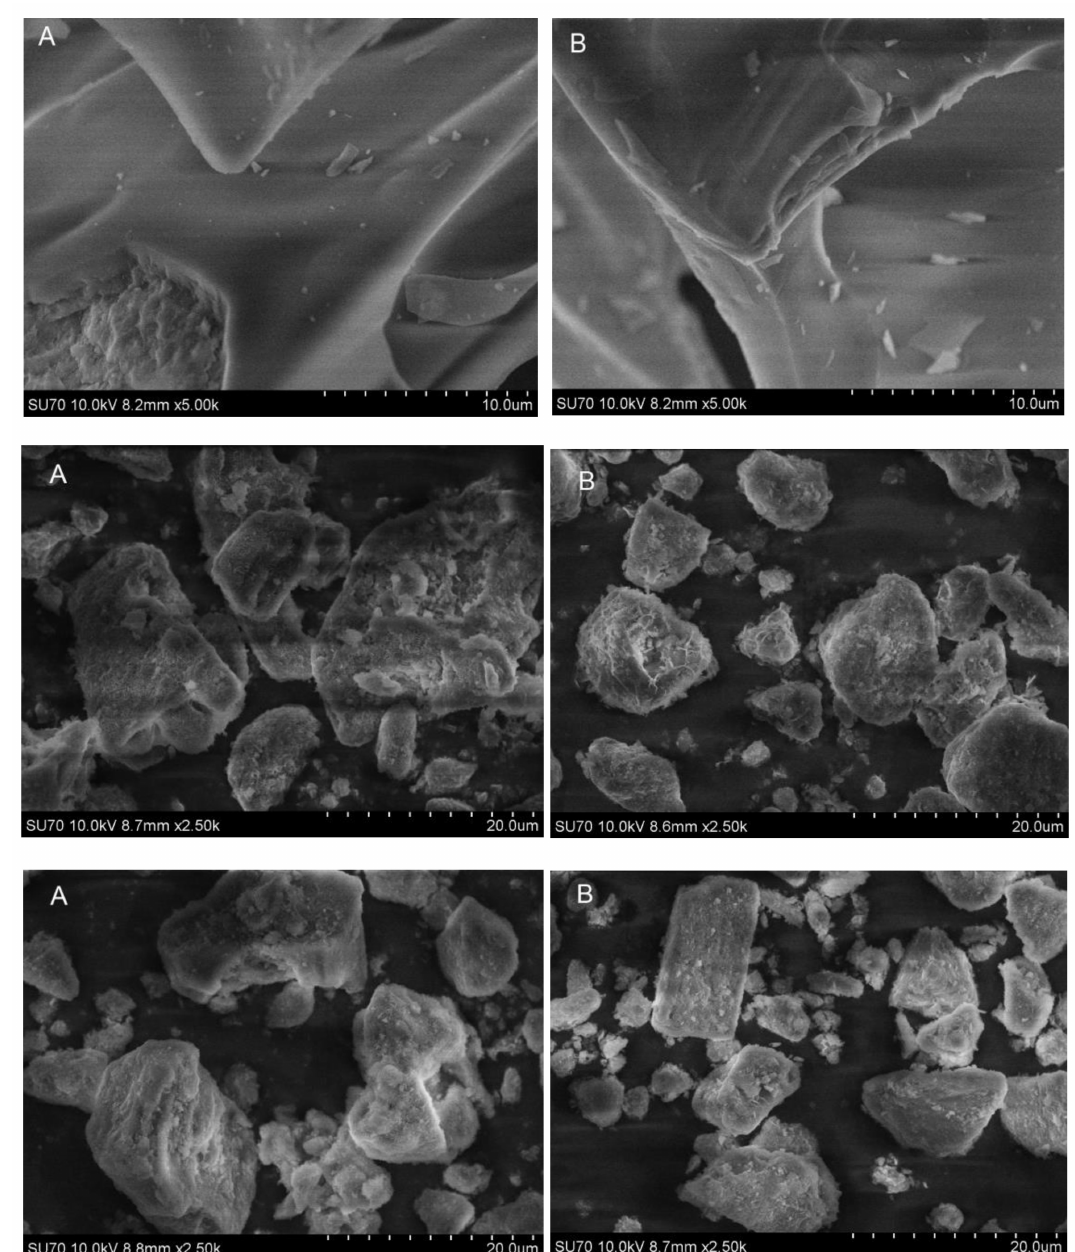
Figure 8. SEM micrographs of MMO obtained by heating the Mg 2 / Al 1 precursor gels ( top ), sol–gel derived Mg 2 / Al 1 LDHs ( middle ) and MMO obtained by heating the Mg 2 Al 1 LDHs ( bottom ). Annealing temperatures: 800 ◦ C ( A ) and 950 ◦ C ( B